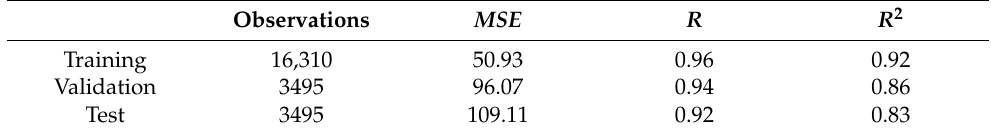
Table 5. ANN regression statistics and MSE .